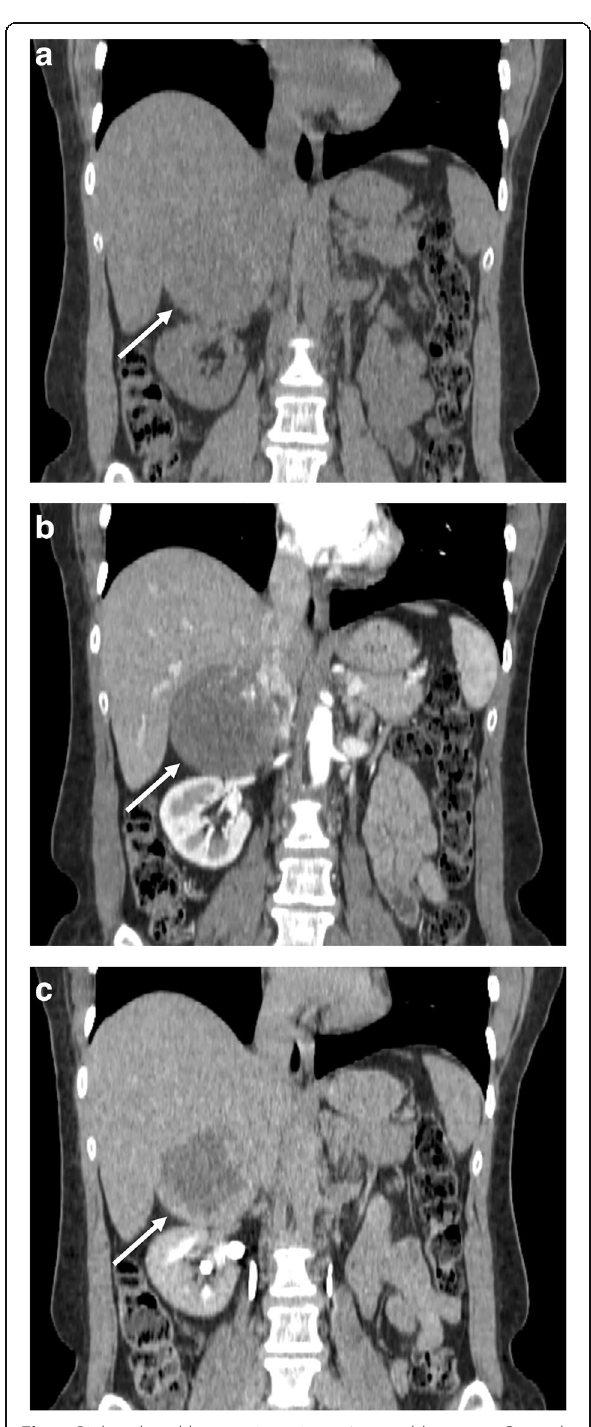
Fig. 7 Right adrenal hemangioma in a 49-year-old woman. Coronal reformatted CT images before ( a ) and after contrast injection in arterial ( b ) and late phase ( c ) show a well-encapsulated large right adrenal lesion (arrow) showing peripheral contrast enhancement with progressive centripetal filling and a hypodense